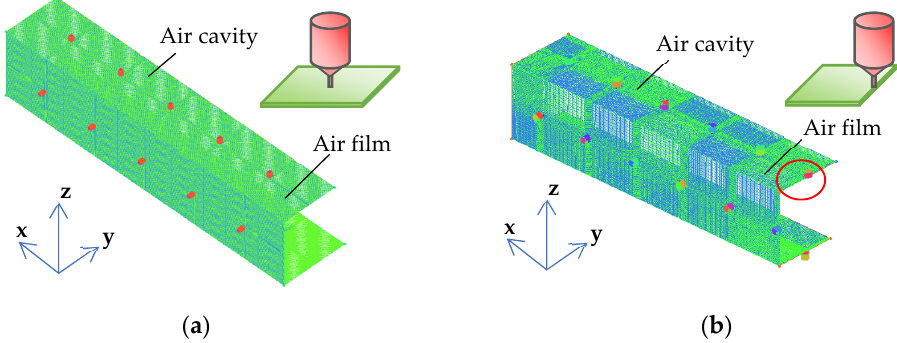
Figure 2. The ( a ) balanced and ( b ) unbalanced air film structure of the cableless aerostatic guideway.